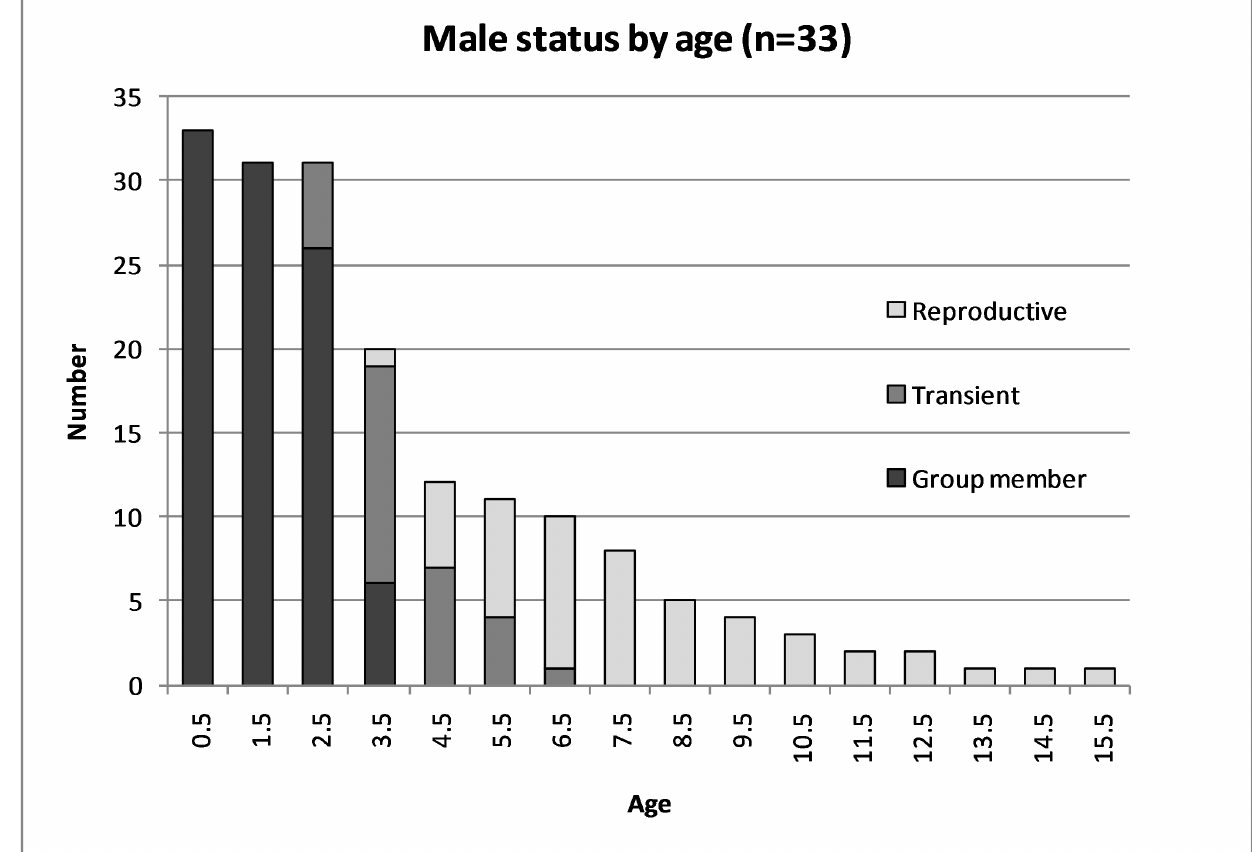
Figure 8. Male status (R - reproductive group member, T - transient, G - non-breeding group member) by age age class (n=33).